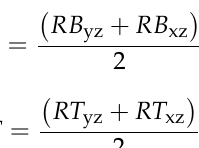
where RB and RT are the local radii of the bottom and top particles, respectively, while RB yz , RB xz , RT yz , and RT xz were obtained from the images of bottom and top grains from two different directions.